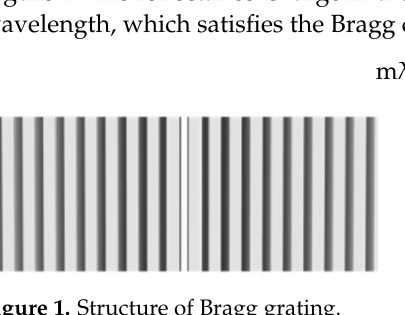
Figure 1. Structure of Bragg grating.